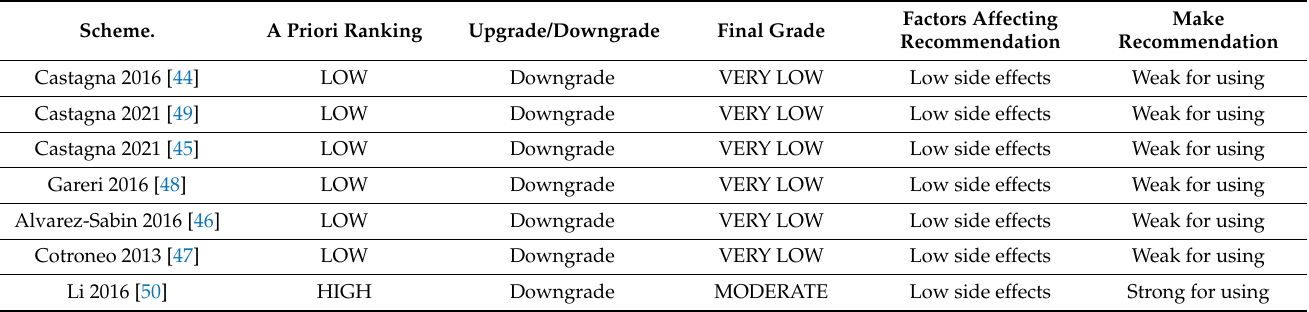
Table 4. GRADE framework (grading of recommendations, assessment and evaluation).